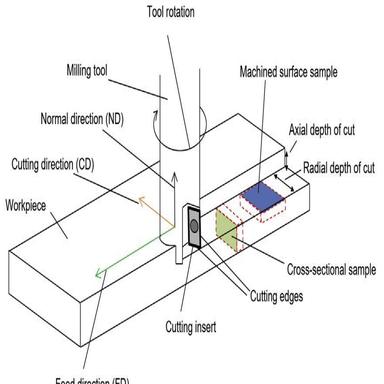
Schematic of the cutting operation highlighting the orientation of samples sectioned from the machined workpiece for surface characterization, as well as the directions referred to in the XRD pole figures and residual stress measurements.